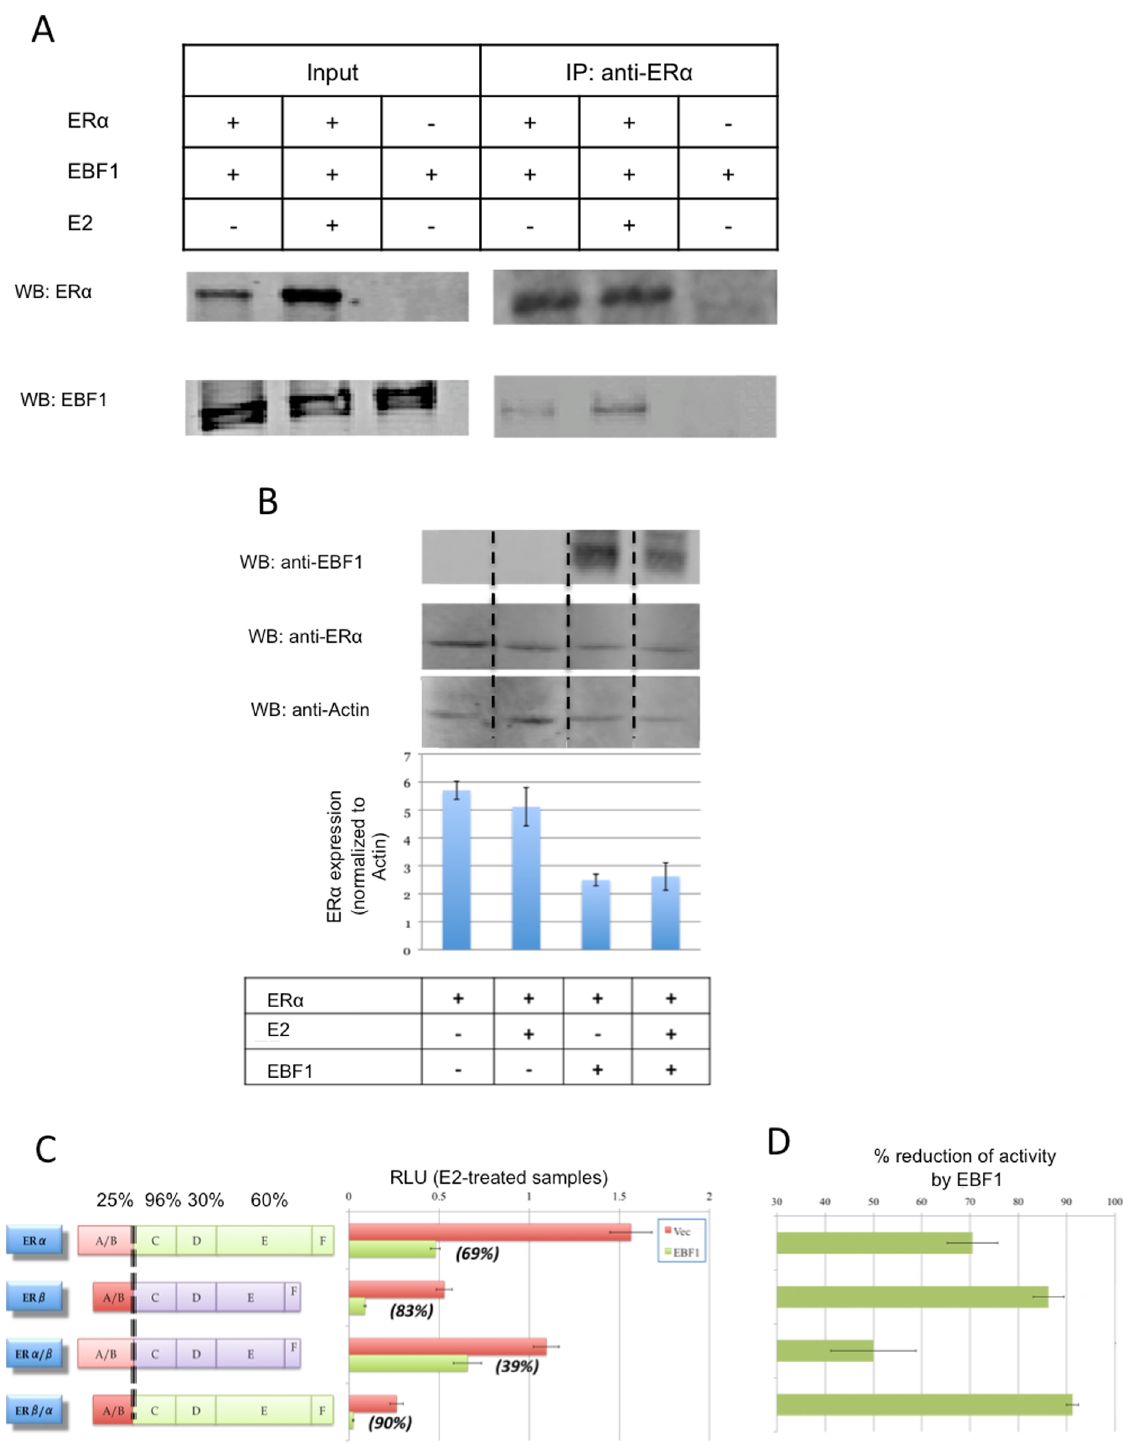
Figure 8. EBF1 differentially regulates ER a and ER b . (A,B) MCF-7/C4–12 cells were transfected with ER a in the presence or absence of EBF1 and then treated with 10 nM E2 or Vehicle control. (A) Association between ER a and EBF1 was confirmed by co-immunoprecipitation assay. (B) ER a protein levels were measured on Western blots (bands from each row were from the same gel but were rearranged to fit the order similar to that shown in figure 7A on ER b ). (C) Transcriptional activities of different ER constructs were measured with the ERE-Luciferase reporter assay in the presence and absence of EBF1; percentages in parentheses represent how much EBF1 affected each construct, as measured by subtracting luciferase signal in EBF1 transfected samples from their vector controls. (D) Effect of EBF1 on ER transcriptional activities measured by subtracting the luciferase signal in EBF1 transfected samples from their vector controls; bar graph represents the average of three independent experiments; error bars represent standard deviations.